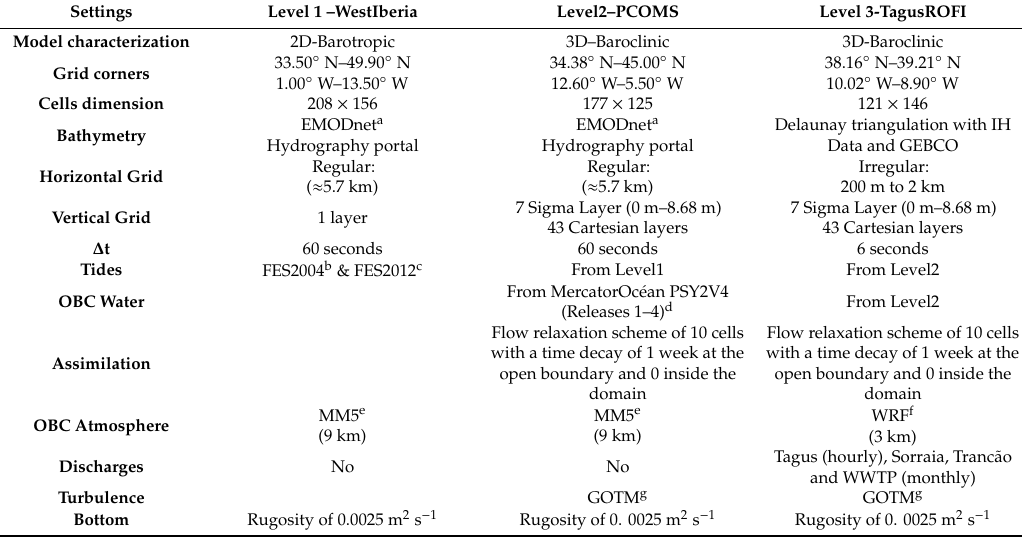
Table 1. Model configuration for the